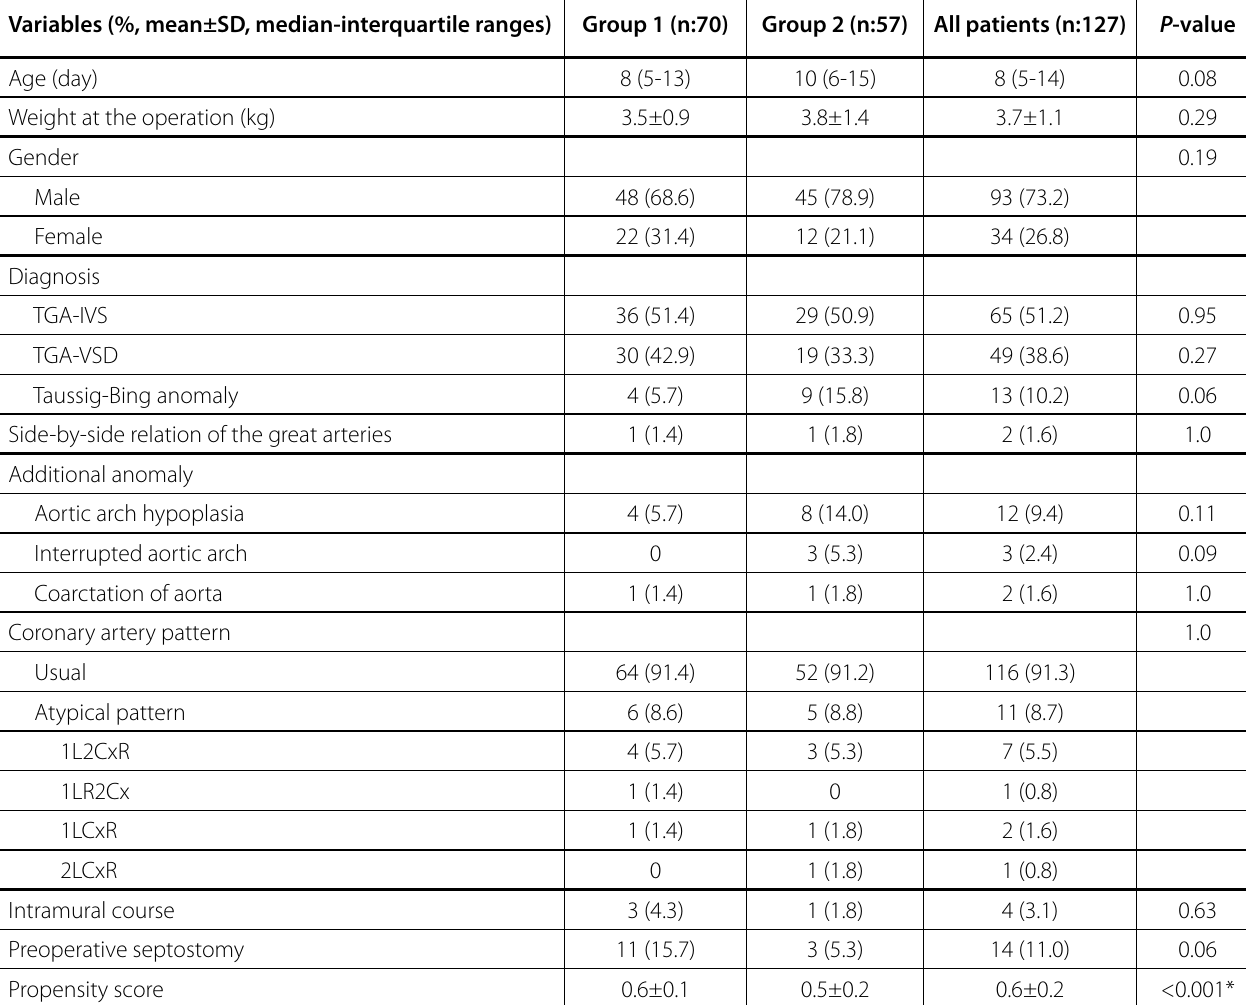
Table 1 . Preoperative patients’ characteristics before the propensity score matching. Variables (%, mean±SD, median-interquartile